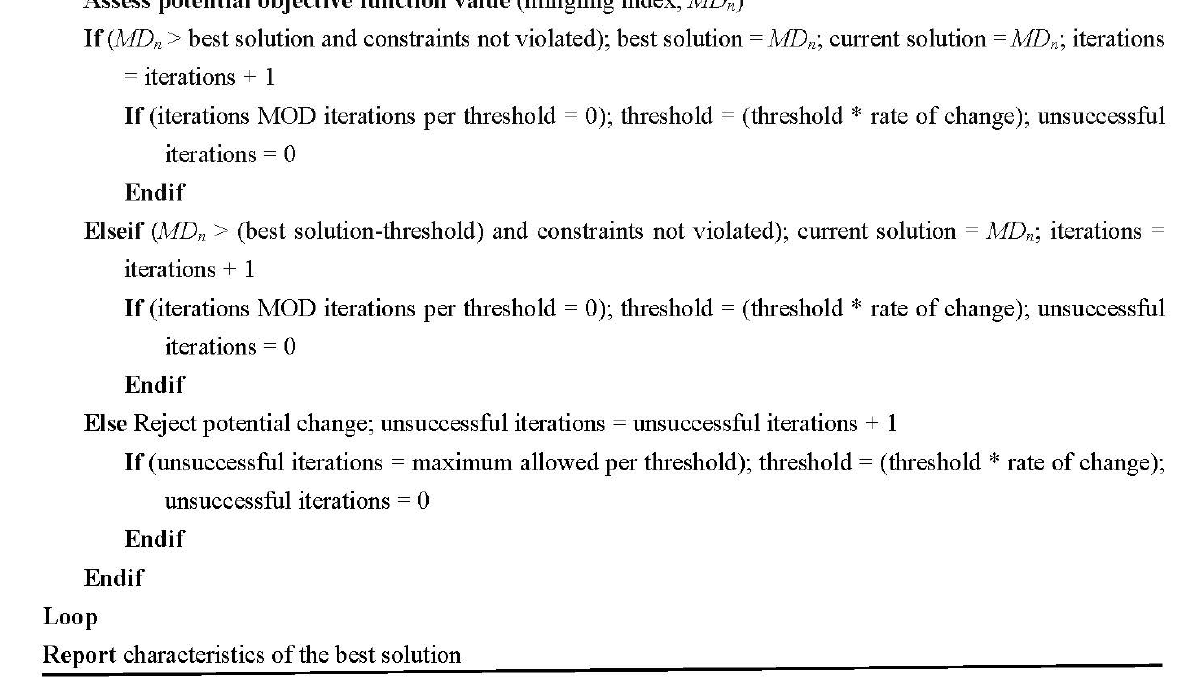
Figure 4. Generalized process flow for the threshold accepting heuristic when applied to a tree-level harvest schedule based on maximizing the species mingling